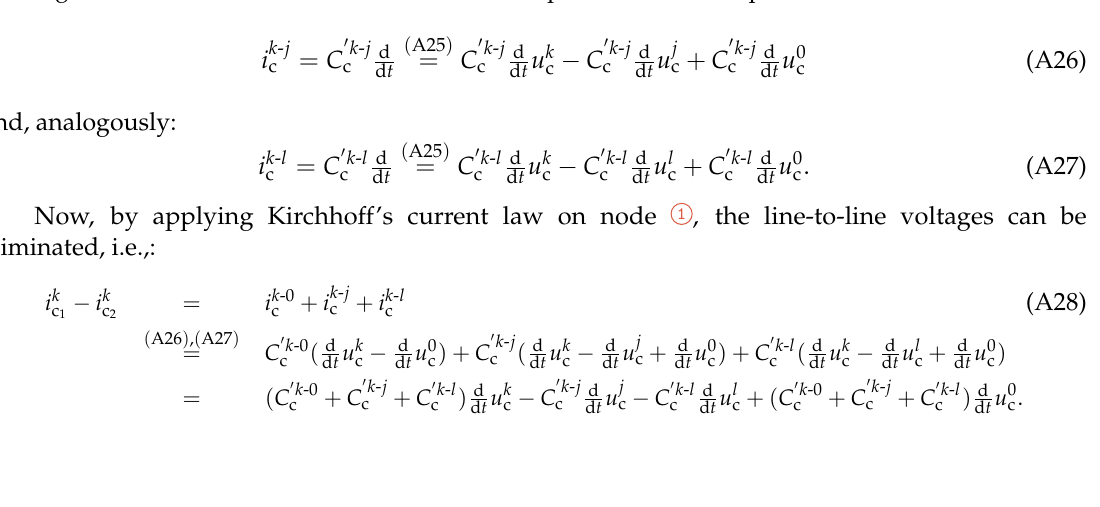
= k and ( b ) currents flowing from and to phase k , j a , b , c ∈ { } (cid:54)